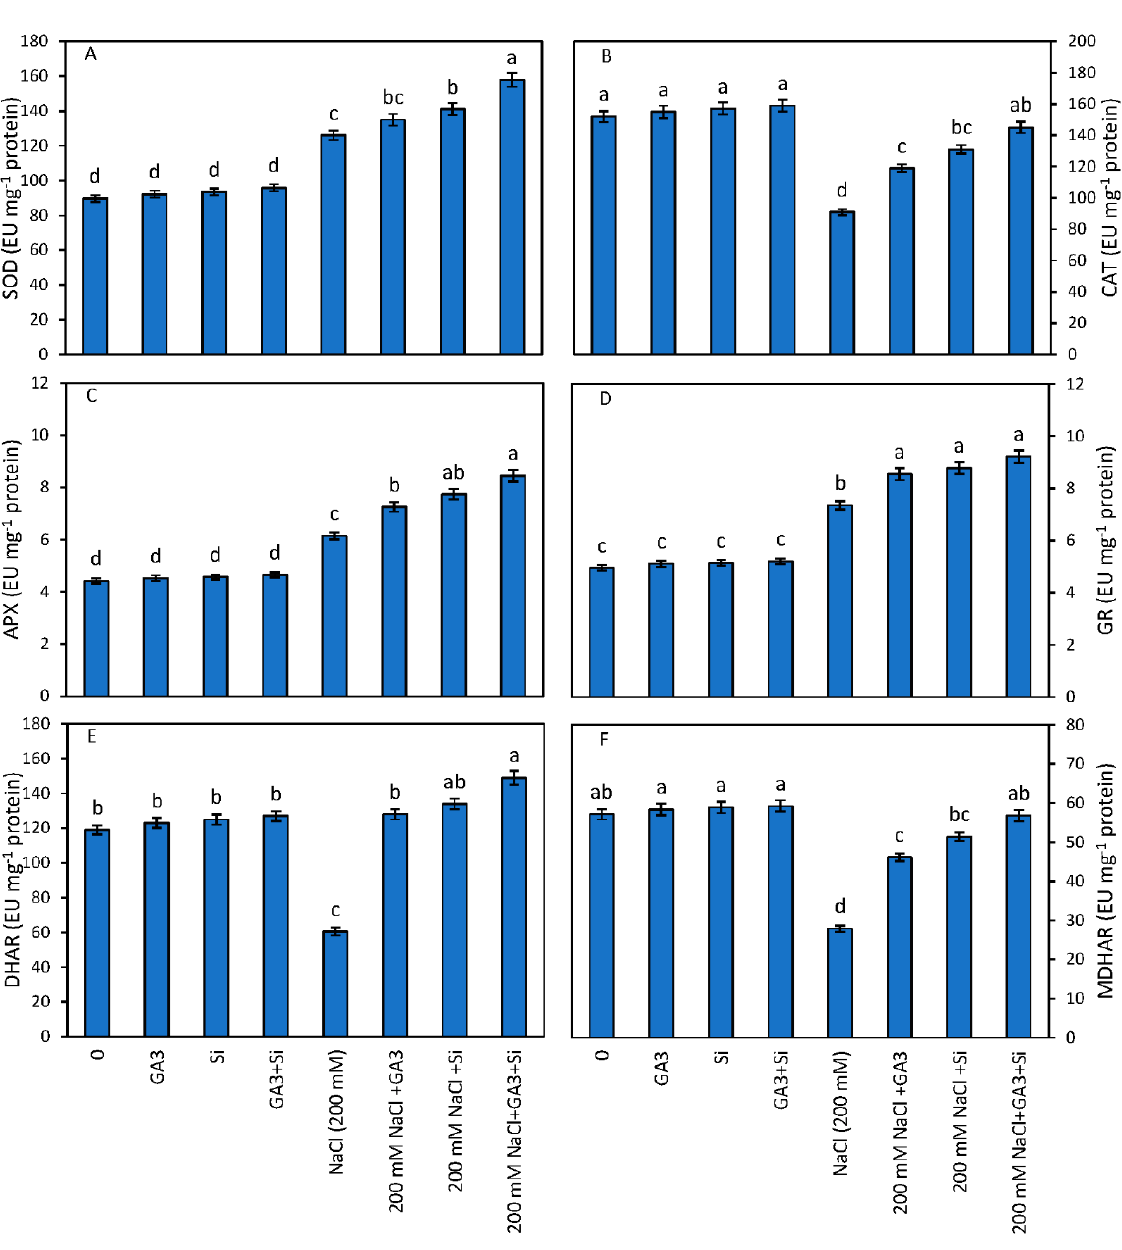
Figure 1. Effect of Gibberellic acid (GA 3 ) and silicon (Si) application on ( A ) SOD, ( B ) CAT, ( C ) APX, ( D ) GR, ( E ) DHAR and ( F ). MDHAR of B. juncea cultivated under NaCl stress. Mean on the column bar that shares a letter with the other entries is not significantly different at p ≤ 0.05 (Bonferroni Test).